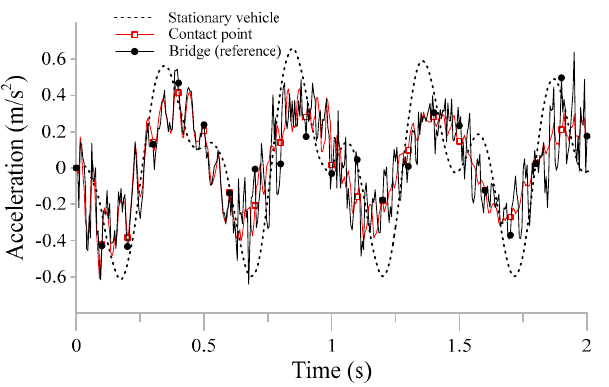
Figure 4. Dynamic response of the stationary vehicle, its contact-point, and bridge acceleration response at mid-span.